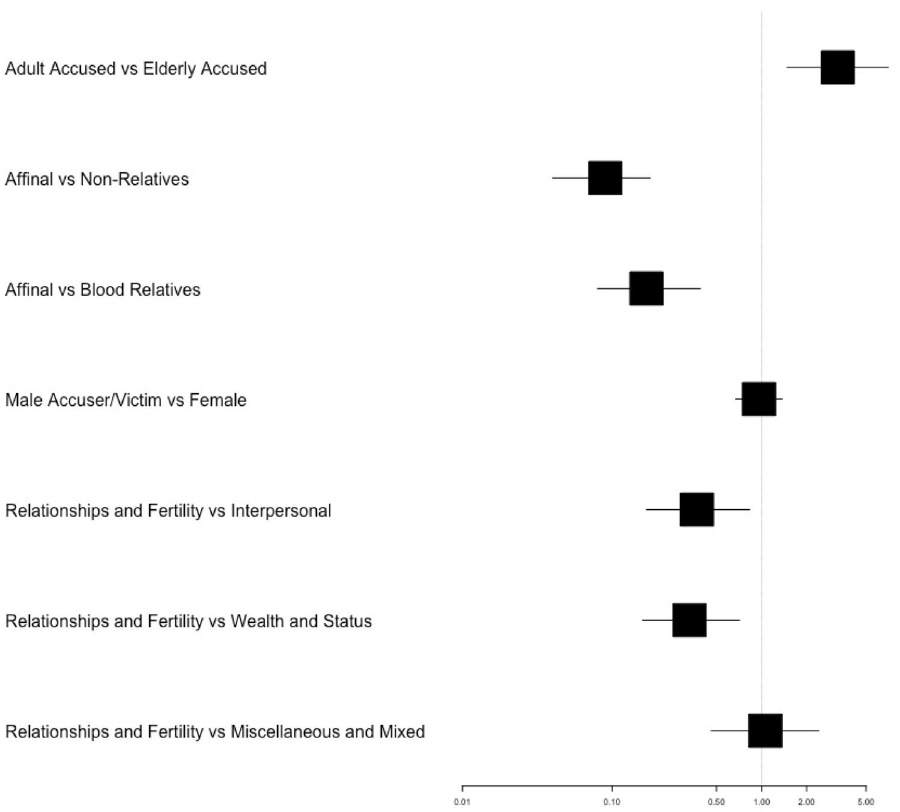
Figure 4. Results from logistic multilevel model-averaging where the outcome variable was the sex of an accused ‘witch’: (0) male or (1) female ( N = 423). Showing model averaged odds ratios and 95% confidence intervals for predictor variables. These are: ( A ) Age of the accused (0) adult or child and (1) elderly. ( B ) Relationship category of the relationship driving the accusation (which may either be that between the accused and the accuser or between the accused and their purported victim): (0) they are affinal kin (1) they are not related (2) they are blood relatives. C. Sex of the accuser or witch’s purported victim. (0) Male (1) Female. ‘NA’ categories are excluded: full model parameters are provided in the Supplementary Materials (Supplementary Table